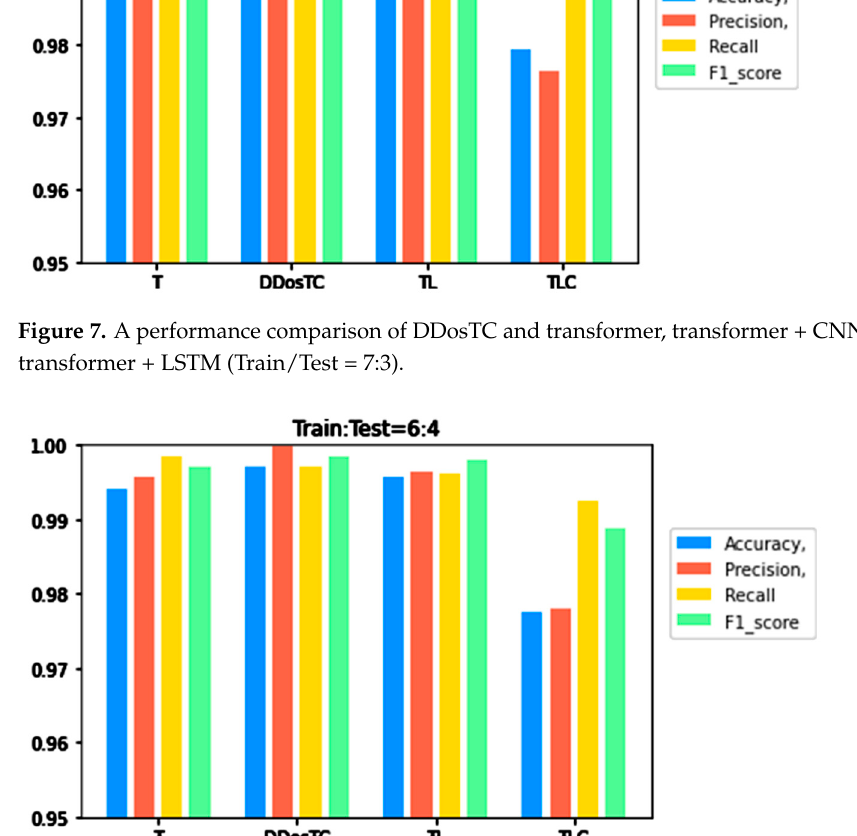
Table 2. A detailed comparison of DDosTC and other models. The bold numbers are our work.